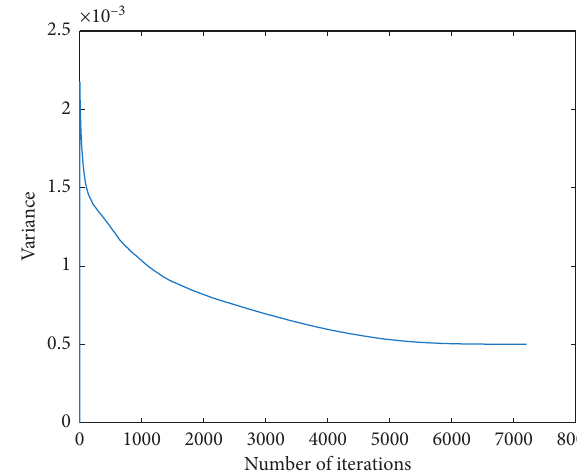
Figure 9: Changes in the variance of AdaMax